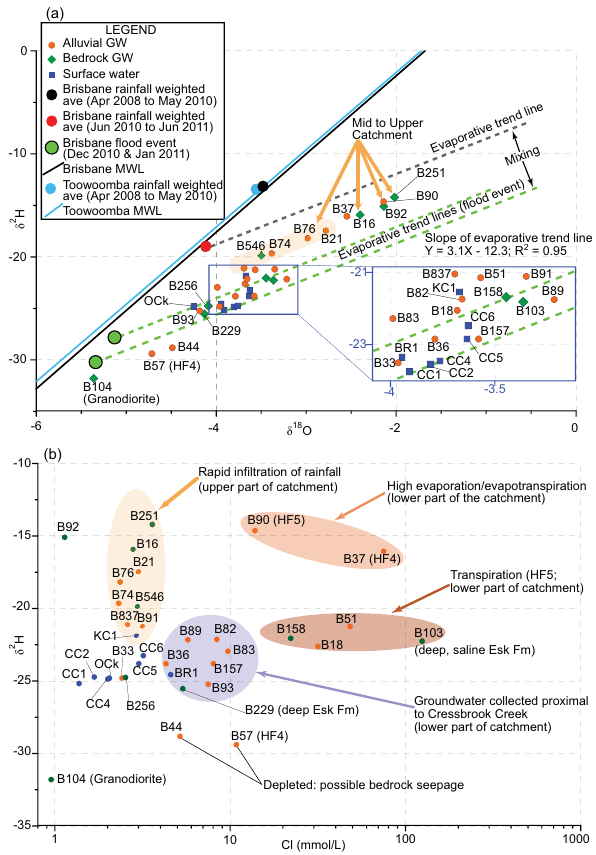
Figure 9. (a) 87 Sr / 86 Sr versus 1 / Sr; (b) 87 Sr / 86 Sr versus tritium; (c) 14 C (pMC) versus tritium; (d) saturation index (SI) for albite versus tritium; and (e) SI for calcite versus tritium. Soil analyses were performed by Douglas et al. (2007), the 87 Sr / 86 Sr ratio for seawater was sourced from Dia et al. (1992), and the rainfall data are from Raiber et al.